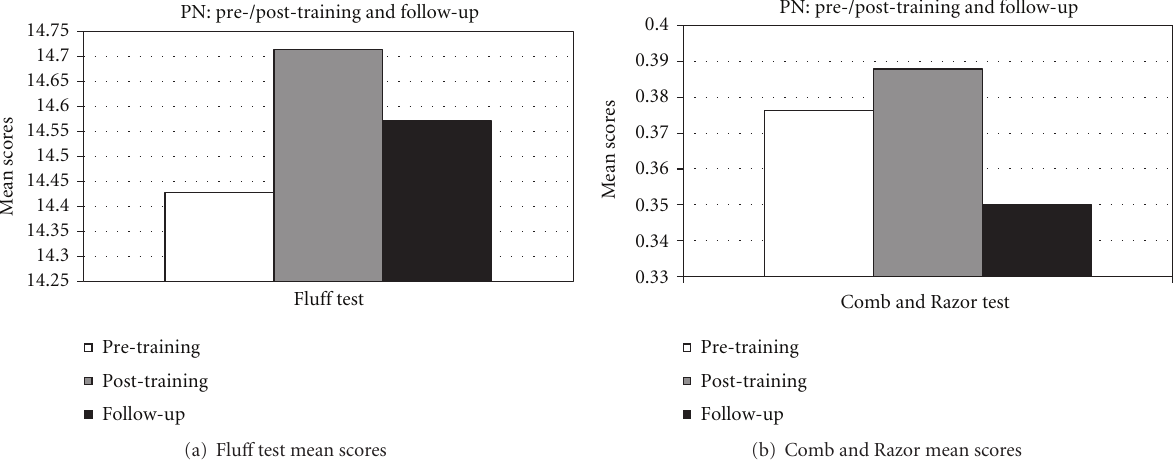
Figure 4: Personal neglect tests in the pre-/post-training and in the follow-up